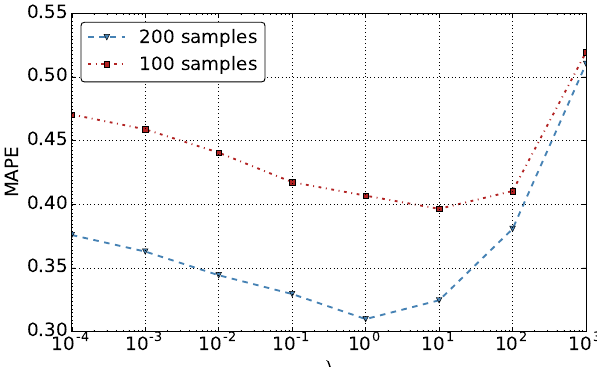
Figure 7. Influence of λ to estimation’s Mean Relative Error when n BS = 200 and n BS = 100 for stress-testing. The figure is based on the November dataset. Results on the December dataset are